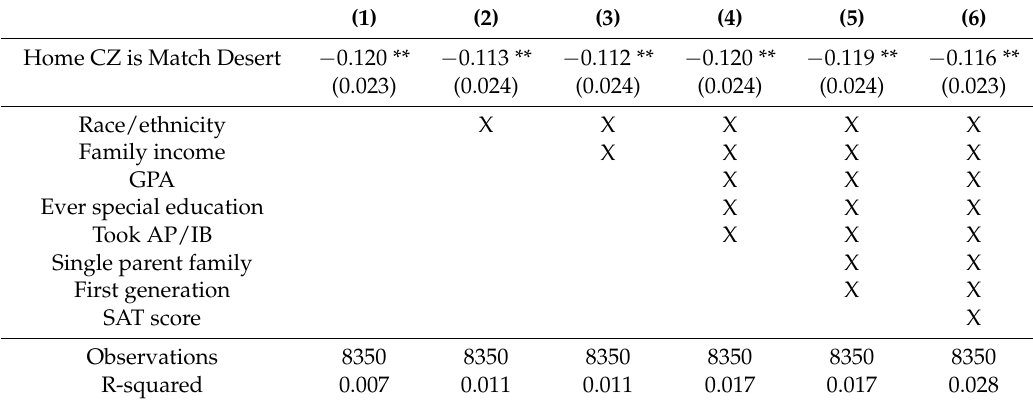
Table 5. Relationship between living in match desert and applying to an academically-matched college. (1)